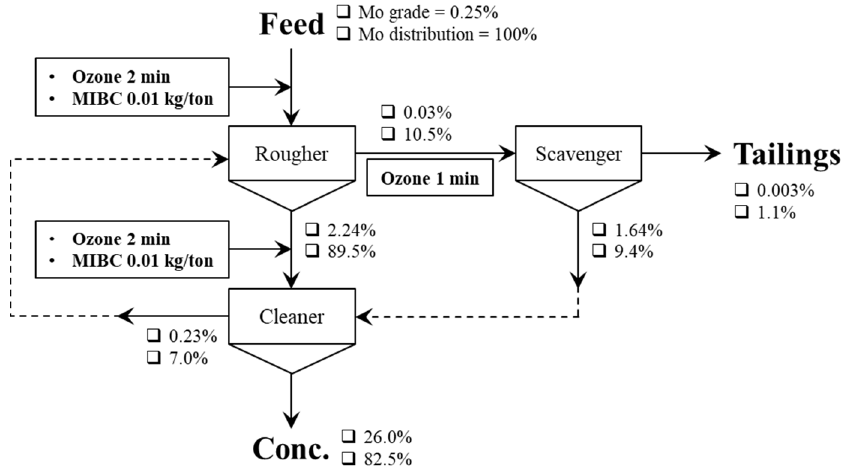
Figure 11. Flowsheet for selective flotation of molybdenite from Cu–Mo concentrates using three-stage ozone conditioning. Dotted lines represent possible recycle streams (reprinted with permission from Ye et al. [69], copyright (1990) Springer Nature).